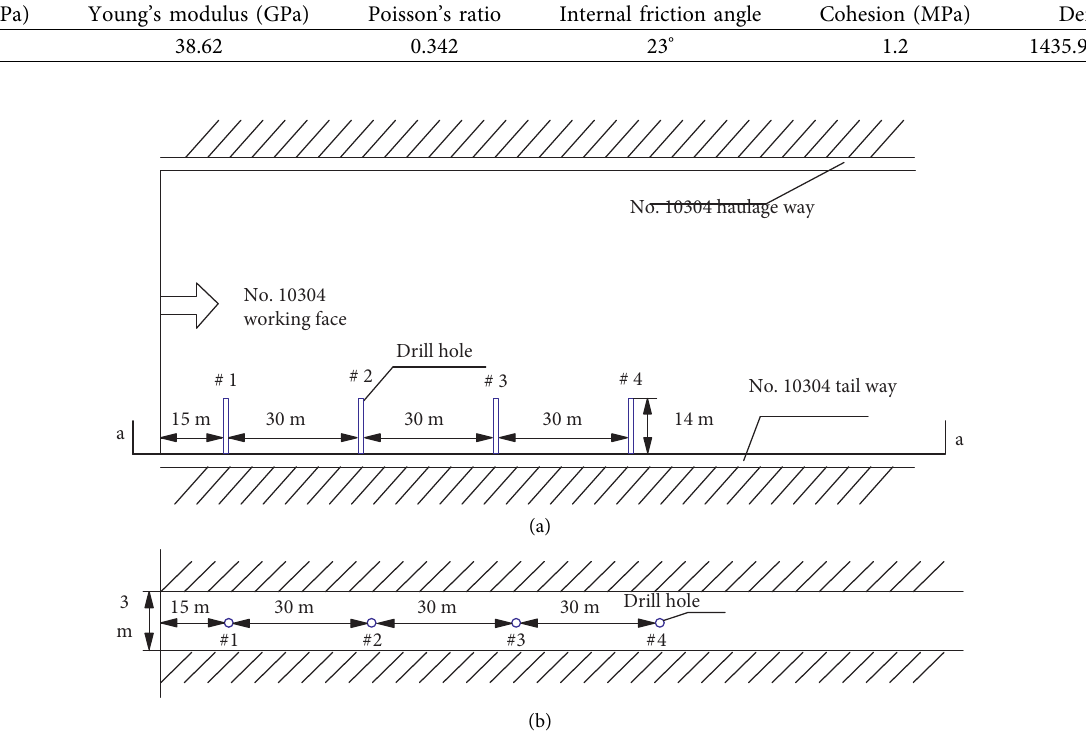
Table 1: The mechanical parameters of coal body in Xinglongzhuang Coal Mine.